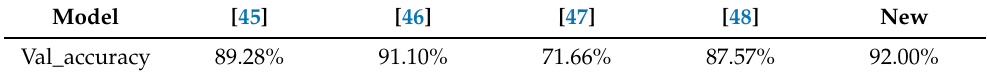
Table 11. Validation accuracy of CIFAR-10 dataset performed with five different classification models.